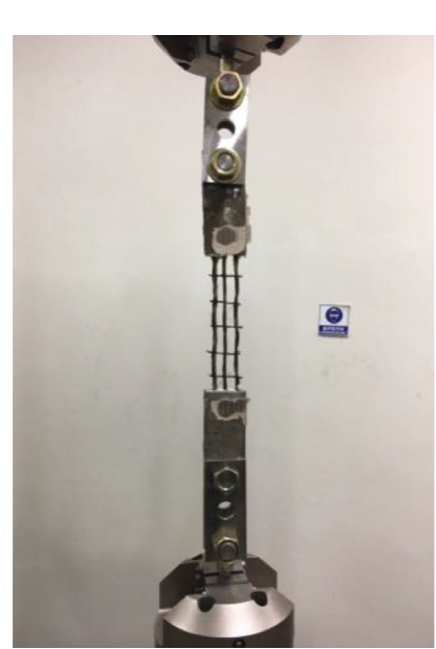
Figure 2: Direct tensile test of FRP